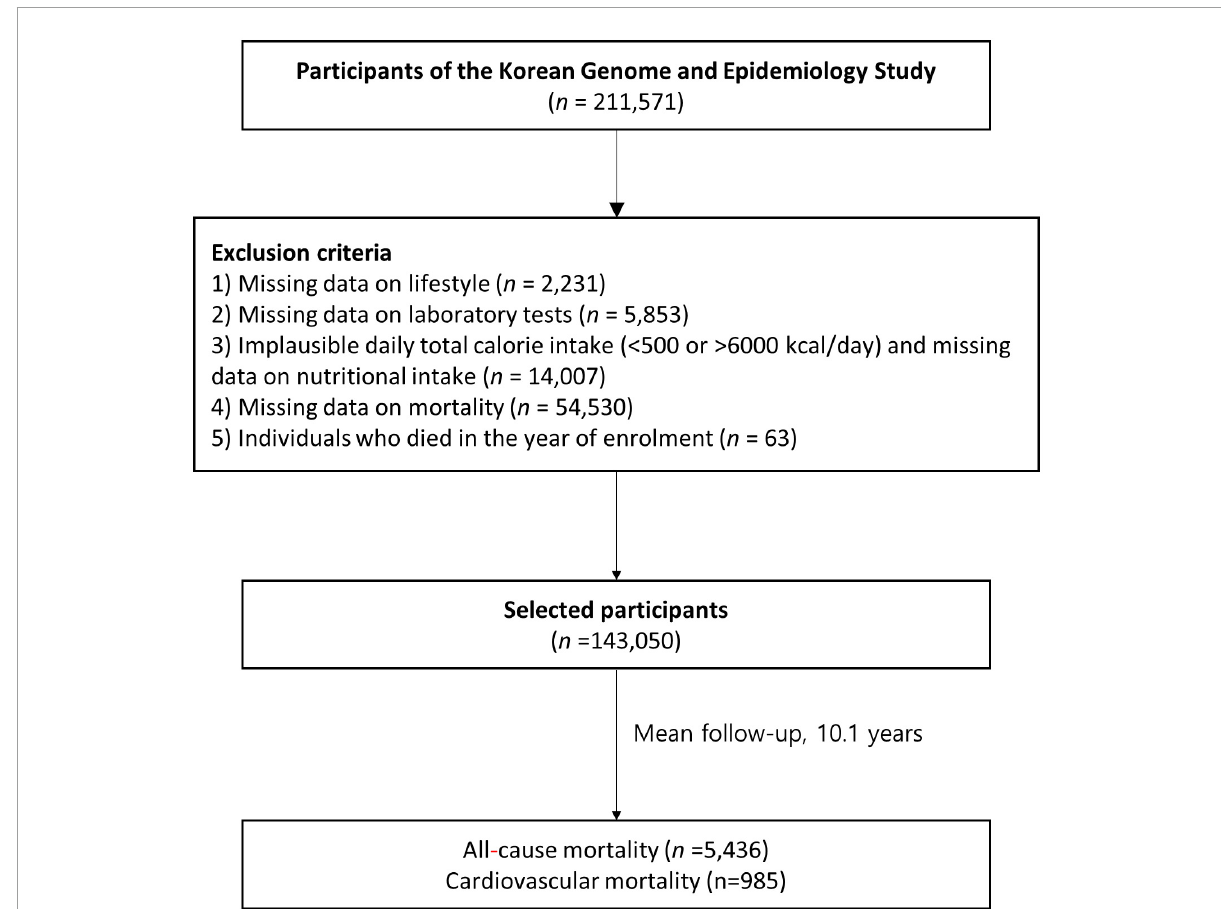
FIGURE1 Flowchart of the participant selection process in this